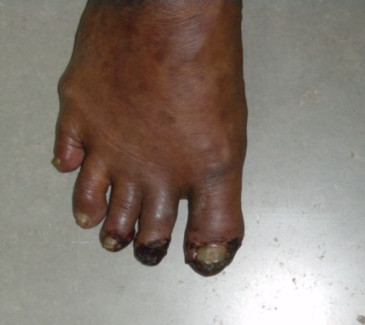
Gangrenous changes.